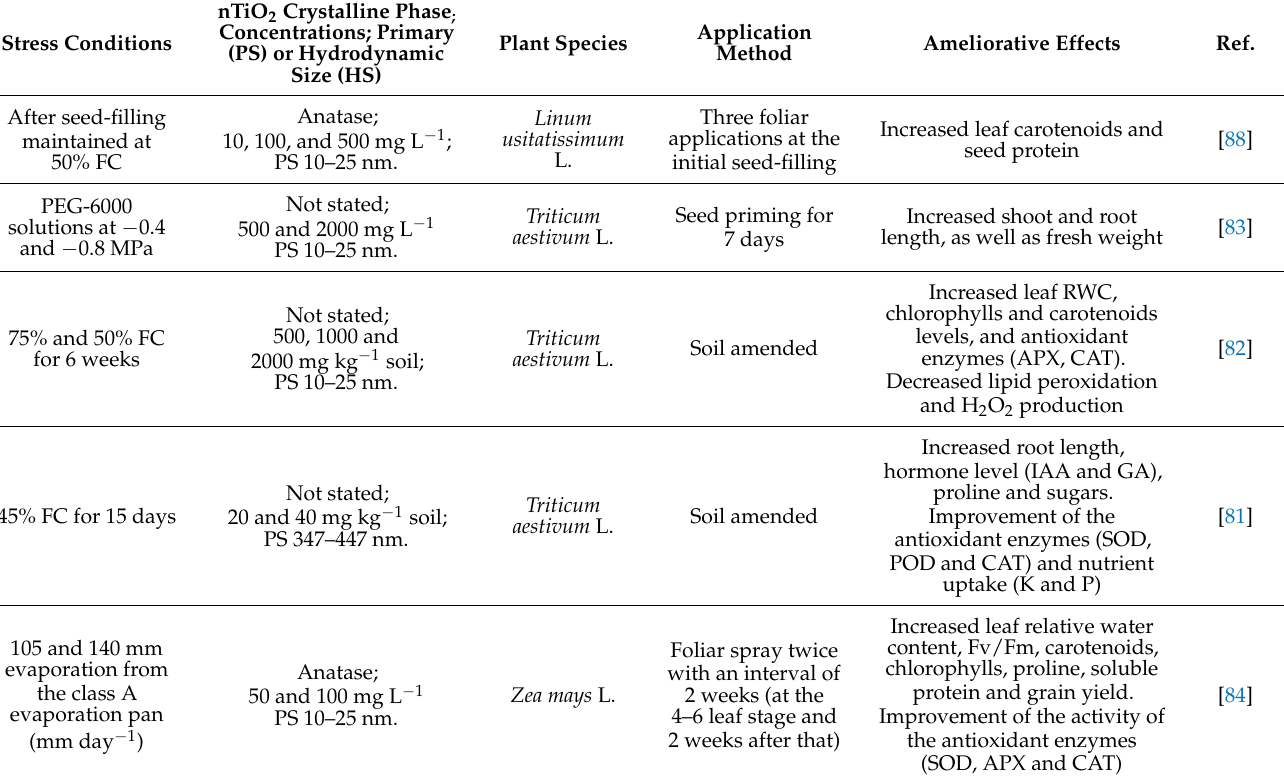
Table 1. Effects of nTiO 2 on plants under drought